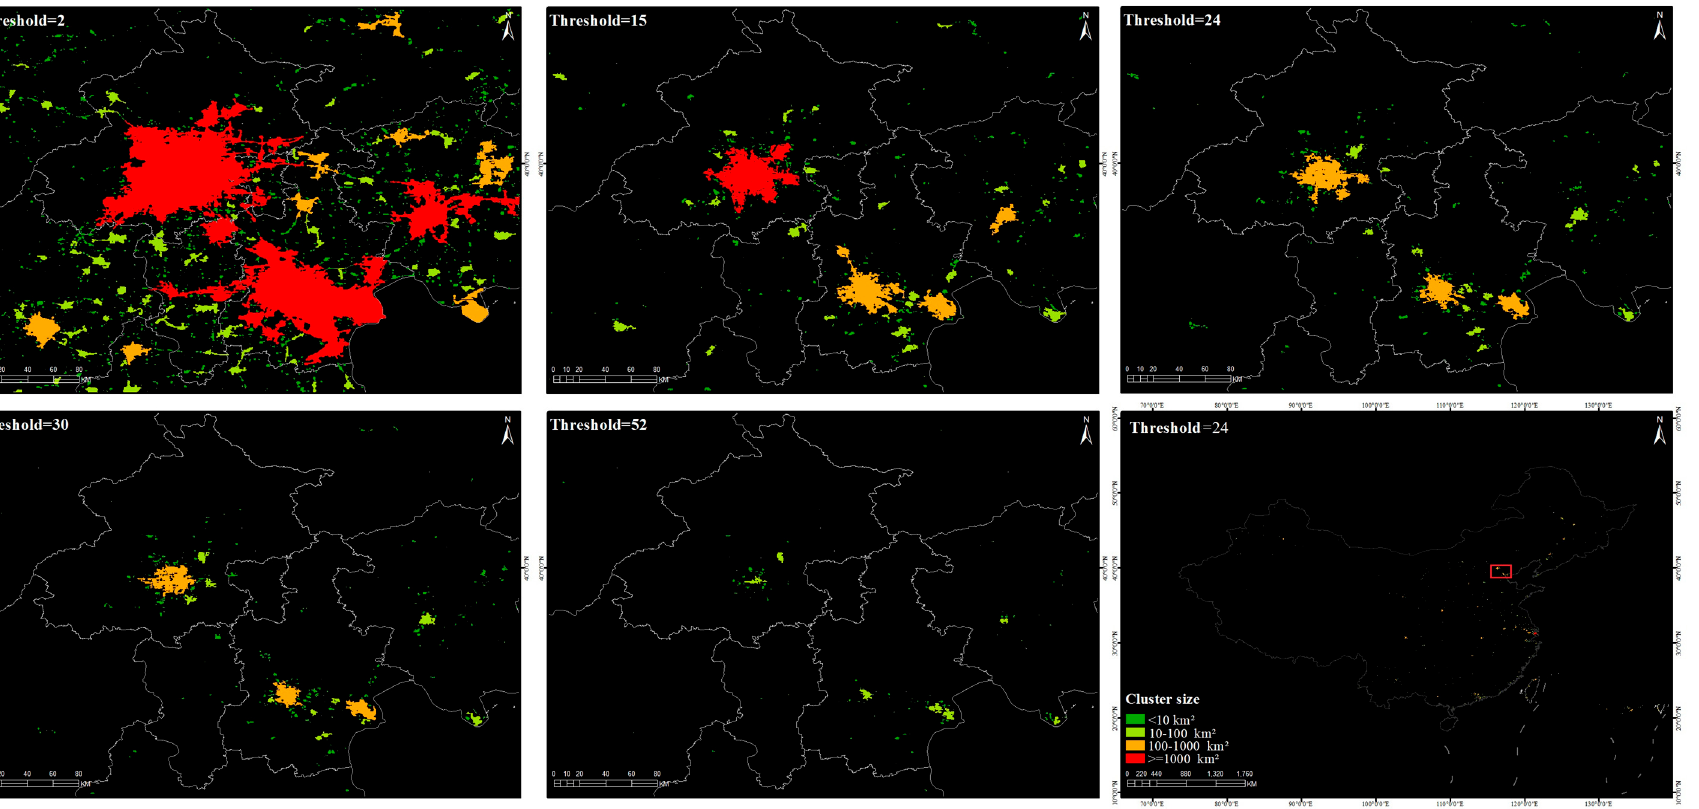
Figure 4. NTL clusters at varying thresholds from NPP-VIIRS data. The first map in the top row shows the NTL clusters at the optimal threshold in China, and the remaining five maps show the enlargement of the Beijing-Tianjin-Hebei metropolitan region when the potential threshold DN P is set to thresholds in different categories, DN P < DN T ( DN P = 2 and DN P = 15), the optimal threshold ( DN P = DN T = 24), DN T ≤ DN P < DN S ( DN P = 30), and DN P ≥ DN S ( DN P = 52). The NTL clusters with different sizes are illustrated in a different color with 0–10 km 2 (green), 10–100 km 2 (peridot green), 100–1000 km 2 (orange), and >1000 km 2